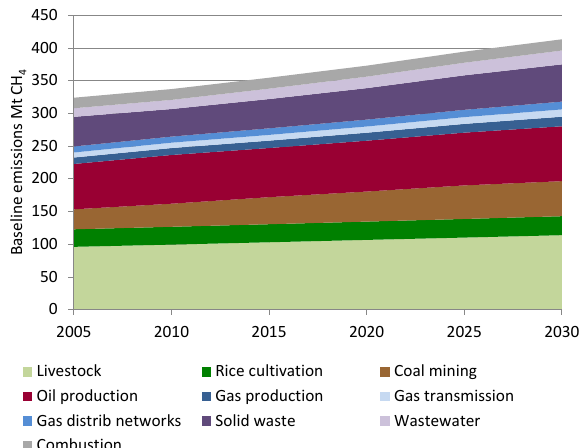
Fig. 3. Global anthropogenic CH 4 emissions with max implemen- tation of available mitigation technology 2005 to